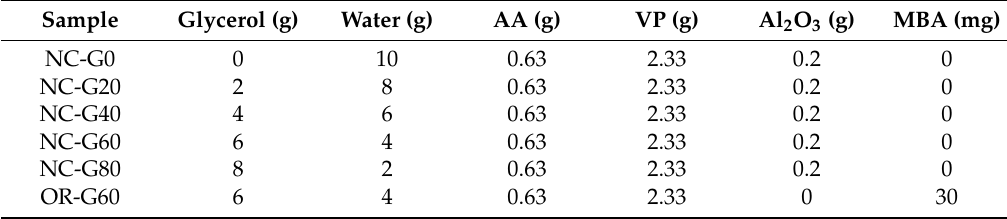
Table 1. Compositions of nanocomposite hydrogels (NC-G gels) and OR-G gel. Sample Glycerol